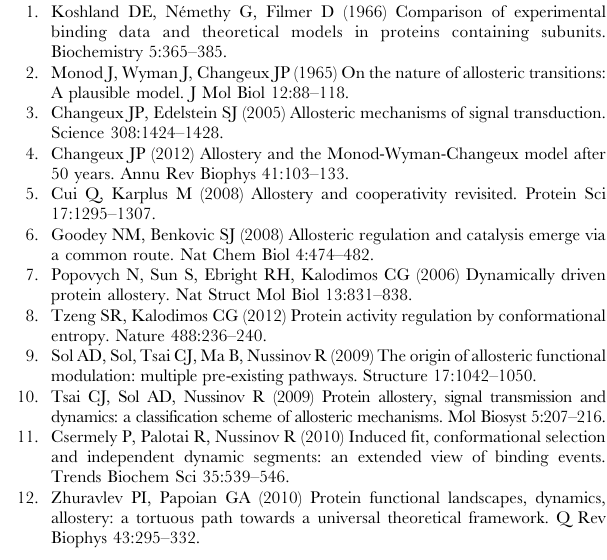
are in green, MD residues are in blue, and CTD residues are in red. The residue-based dynamic profiles are annotated using the residue numbering in the original crystal structure [61]. The peaks of the force constant profiles corresponding to functionally important residues are indicated by arrows and annotated. Functional residues corresponding to the peaks in the force constant distribution are mapped onto the domain-colored crystal structure of the ATP-bound Grp94 (B) and onto the functional dynamics profile of the ATP-bound Grp94 (C). Functional residues are annotated and shown in spheres and colored as in Figure 4. Figure S3 Nucleotide-Specific Modulation of Solvent Accessibility in the Hsp90 Structures: The Ensemble- Based Differential Profiles. The ensemble-based differential profiles of solvent accessibility are based on a computational procedure for calculating the depth of a residue from the protein surface [100]. The effect of nucleotide binding is evaluated using differential plots of the residue depth profiles between ATP-bound HtpG and apo-HtpG (A) and between ATP-bound yeast Hsp90 and apo-Hsp90 (B). The computed profiles are directly compared with the HX-MS experiments, showing ATP-induced protection in the key functional regions. The functional regions that experienced considerable nucleotide-specific changes in the residue depth profiles are annotated and indicated by ovals. Figure S4 Structural Alignment of the Interaction Communities with the Conformational Dynamics Pro- files of Hsp90. The network-based interaction communities are mapped onto the conformational dynamics profiles of the Hsp90 structures in the space of principal modes. Structural maps of communities are shown for the solution structure of HtpG (A), the crystal structure of apo HtpG (B), the crystal structure of ADP- HtpG (C), the crystal structure of ATP-Grp94 (D), and the crystal structure of yeast ATP-Hsp90 (E). The functional dynamics profiles are obtained using PCA of the MD-based conformational ensembles averaged over three lowest frequency modes. A ribbon protein representation is employed. The color gradient from blue to red indicates the decreasing structural stability (or increasing conformational mobility) of protein residues. The residues in the